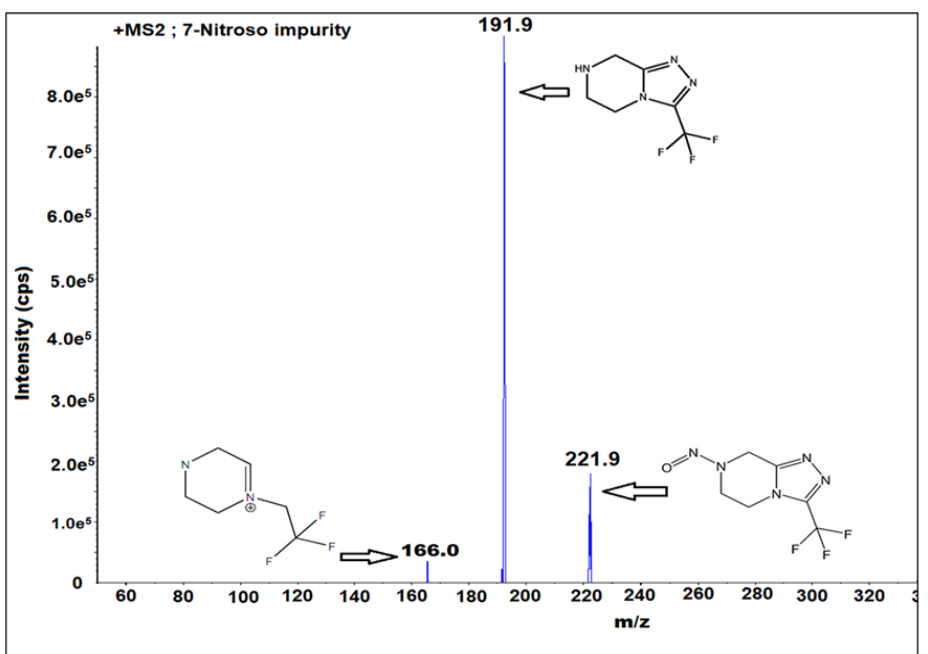
Figure 2. Fragmentation pattern of 7-nitroso impurity m/z 221.9, N-NO bond cleavage and formation of m/z 191.9 and probability of nitrogen molecule elimination from m/z 191.9 and formation of m/z 166.0 in the mass ionization chamber. Table 1. Liquid chromatographic and mass spectrometric method